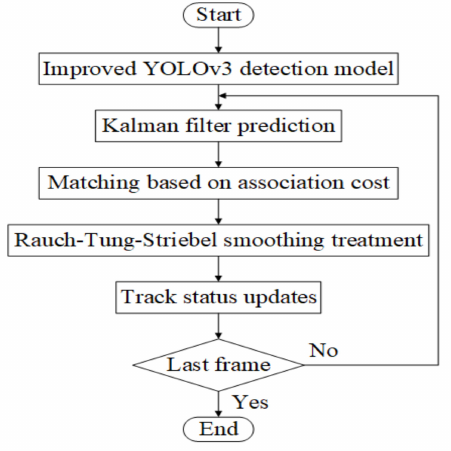
Figure 4. Vehicle trajectory tracking